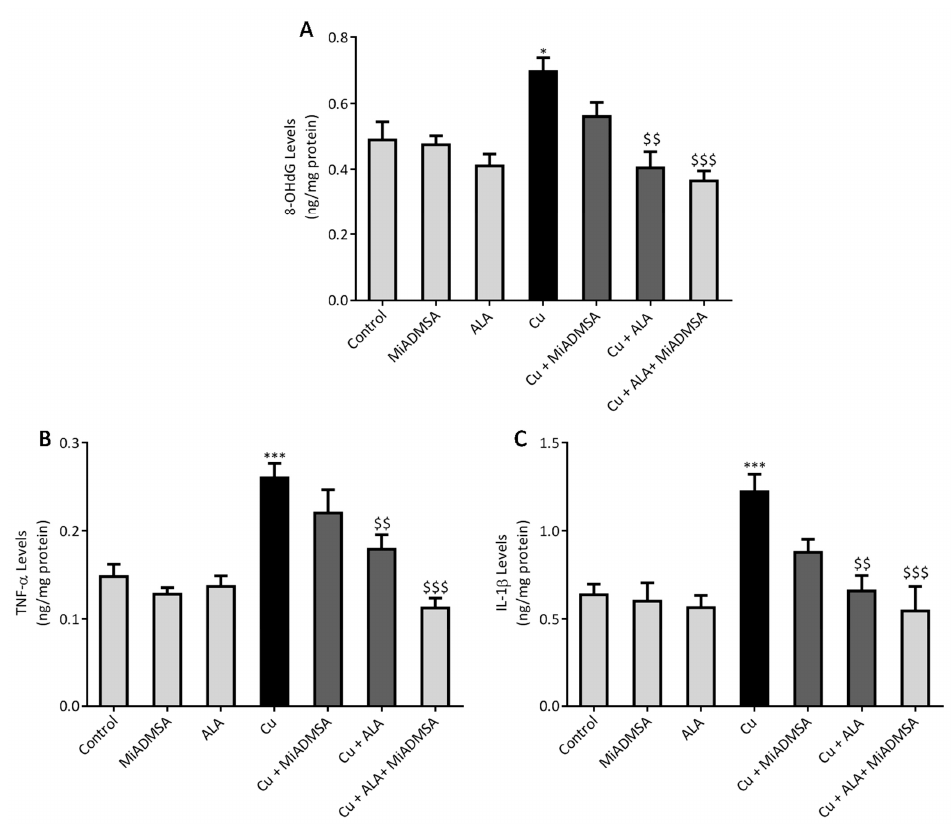
Figure 13. The combination therapy of MiADMSA and ALA diminished the brain 8-OHdG, TNF- α , and IL-1 β levels. ( A ) Brain 8-OHdG level;( B ) Brain TNF- α level; ( C ) Brain IL-1 β level. All the values are expressed as mean ± S.E.M. ( n = 6), *** p < 0.001 vs. control and $$ p < 0.001, $$$ p < 0.001 vs. Cu. *: It indicates the comparison between the groups which we have mentioned in the figure legends.